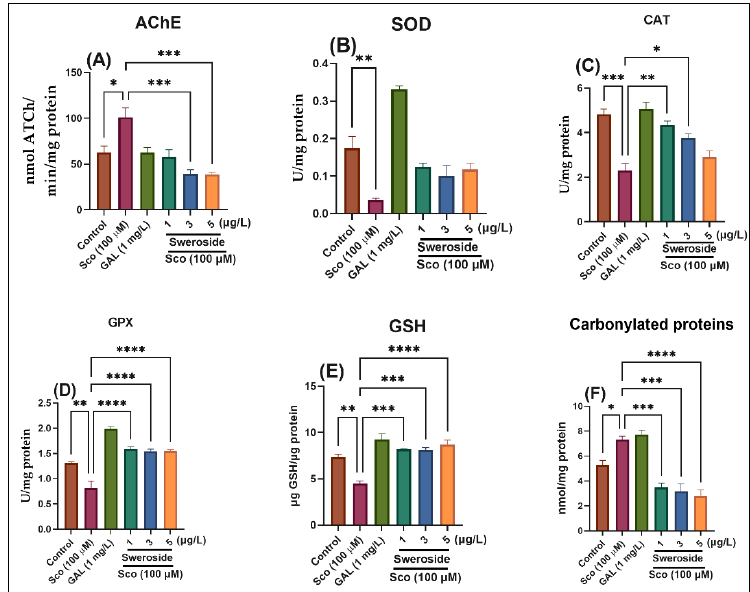
Figure 4. Effects of sweroside (2.79, 8.35, and 13.95 nM) on ( A ) AChE; ( B ) Superoxide dismutase (SOD); ( C ) Catalase (CAT)- ( D ) glutathione peroxidase (GPX)-specific activities; ( E ) Reduced gluta- thione (GSH) and ( F ) carbonylated protein levels. Data are represented by means ± S.E.M. ( n = 10 animals per group). * p < 0.01, ** p < 0.001, *** p < 0.0001, and **** p < 0.00001 (Tukey’s post hoc analyses). Galantamine (GAL, 2.71 μ M) was used as a reference positive drug.